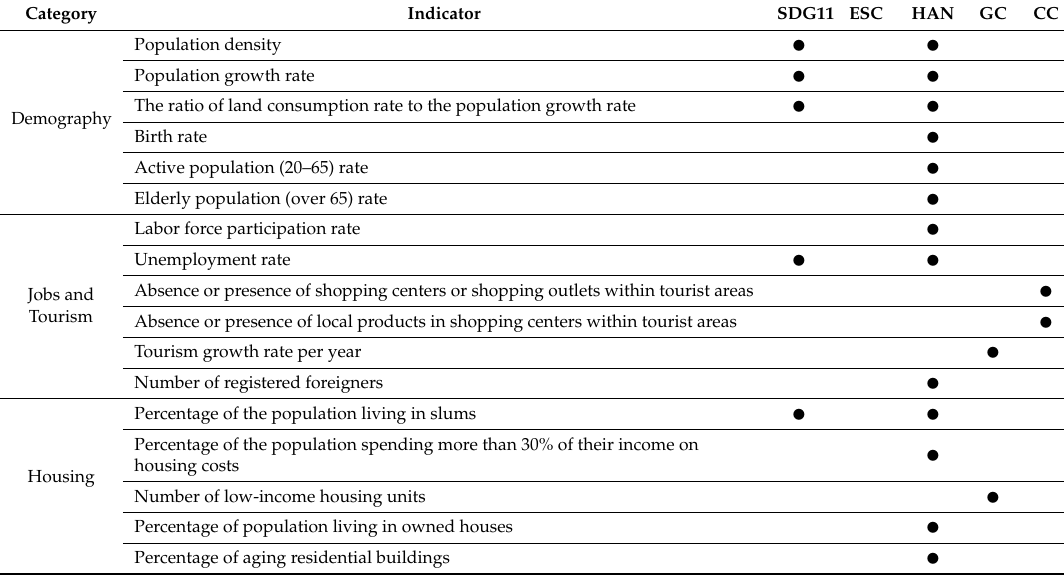
Table A1. Review and classification of the five major source